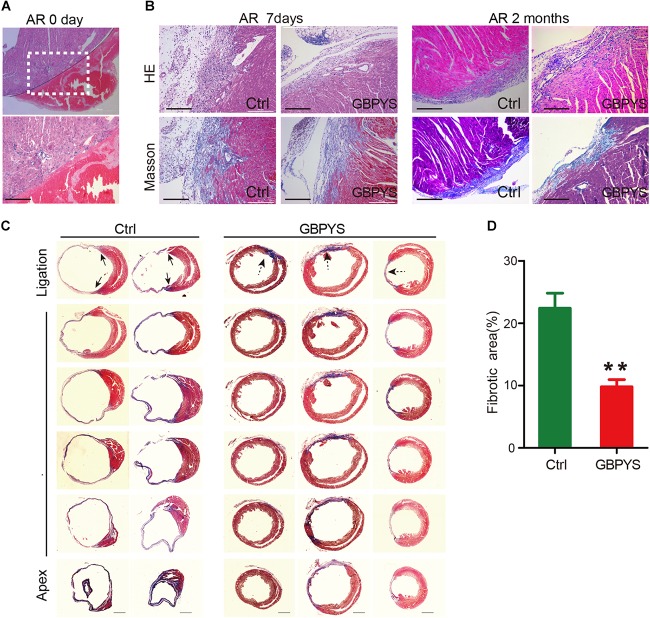
GBPYS feeding reduced scar size after myocardial damages. (A) Representative HE staining of heart sections of mice with apical resection at day 0. A hematoma can be clearly observed after apical resection at day 0. The lower panel represents the boxed area in the upper panel. Scale bar, 100 μm. (B) HE and Masson’s trichrome staining showed reduced fibrosis area in GBPYS-fed apex-resected mice at 2 months after apical resection. Scale bar, 100 μm. (C) Masson’s trichrome staining of serial sections of hearts from MI mice after 2 months feeding, n = 8 per group. Solid arrows, scar boundaries; dotted arrows, ischemic region. Scale bar, 2 mm. (D) Quantification of fibrotic area relative to myocardium in trichrome-staining sections demonstrated a significant decrease in scar formation in the GBPYS-feeding mice (n = 7 for Ctrl and n = 8 for GBPYS feeding group). ∗∗P < 0.01.